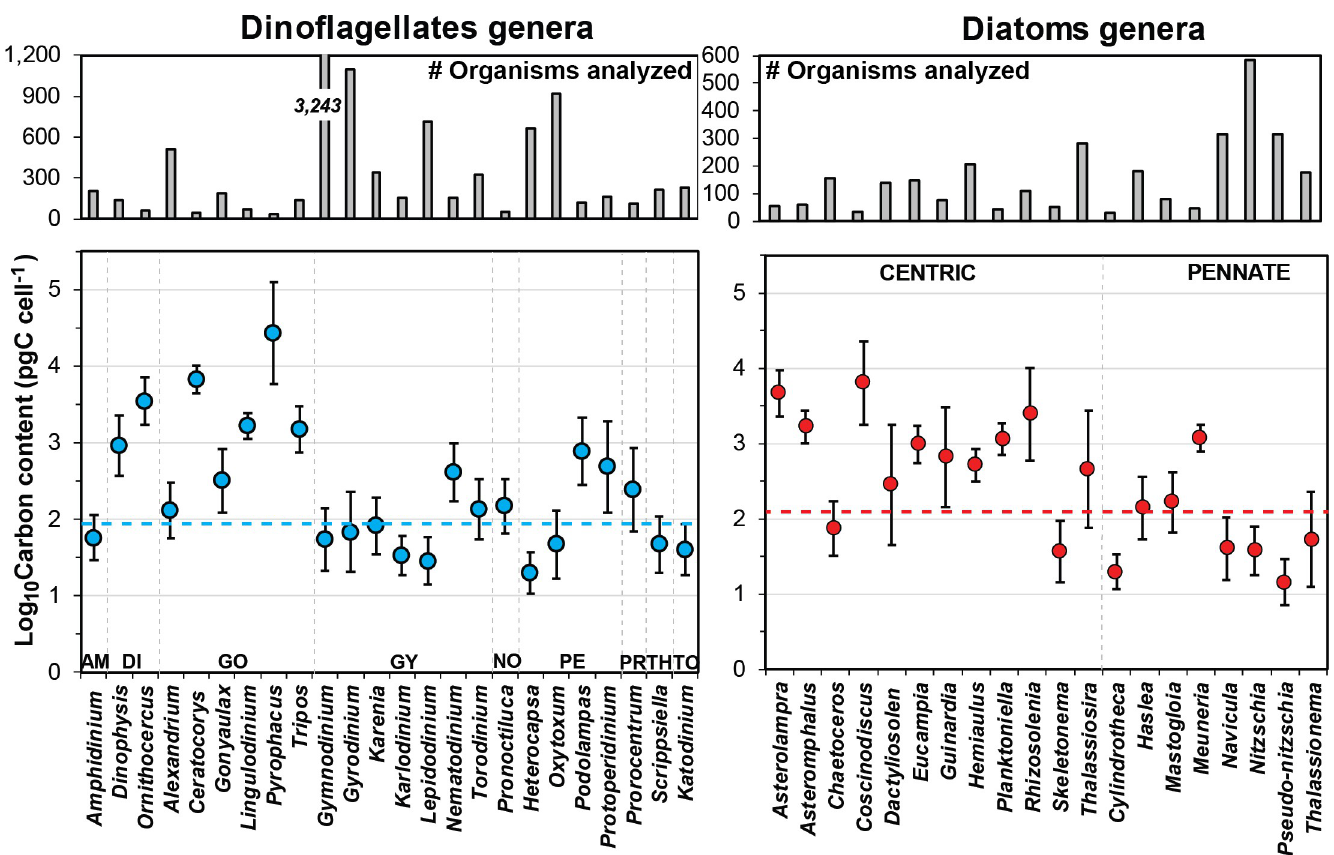
Fig 6. Logarithmic (Log 10 ) mean ( ± SD) of carbon content (pg C cell -1 ) for phytoplankton genera. Average log-values of carbon per cell (pg C cell -1 ; lower panels) for genera of dinoflagellates (blue points) and diatoms (red points). Only taxa with more than 30 cell measurements per genus were included. Grey bars in the upper panels indicate the number of organisms analyzed for each genus. Blue and red dashed lines represent average carbon per cell of total dinoflagellates and diatoms, respectively. Dinoflagellate orders: AM, Amphidiniales; DI, Dinophysales; GO, Gonyaulacales; GY, Gymnodiniales; NO, Noctilucales; PE, Peridiniales; PR, Prorocentrales; TH, Thoracosphaerales; TO,